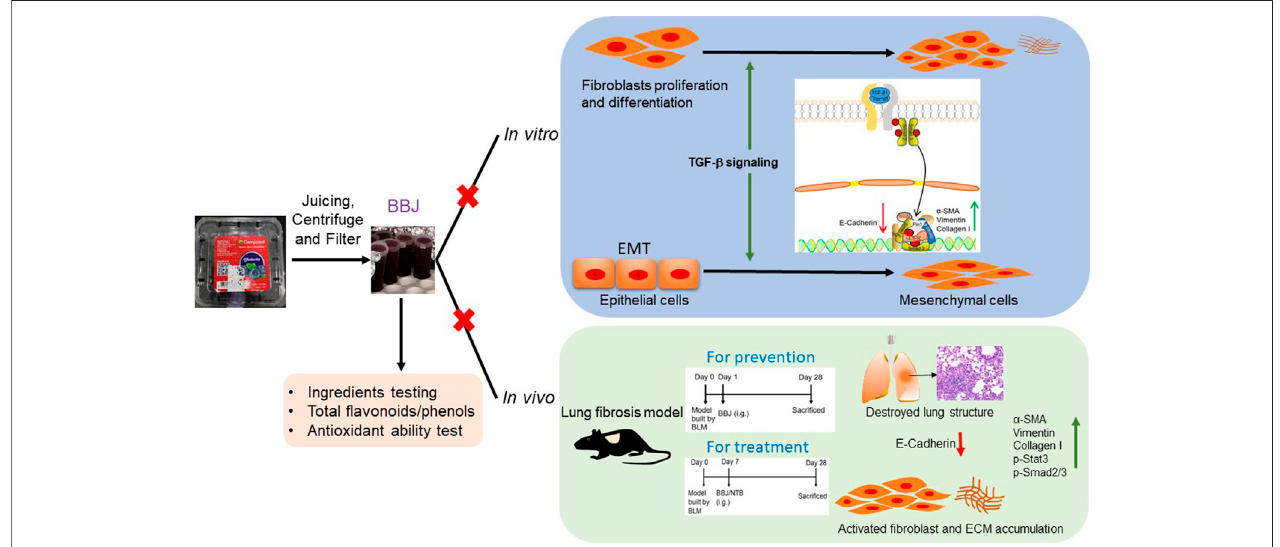
FIGURE 7 | BBJ could inhibit lung fi brosis in vivo and in vitro . Followed by aseriesof processing, BBJ was utilized in assays in vitro and in vivo . BBJ was proven to inhibitEMTinA549.BBJcouldalsosuppress differentiationof fi broblaststomyo fi broblasts inducedbyTGF- β 1provedbythechangesofrelated proteins. Inaddition, in lung fi brosis, the C57BL/6 mouse model built by BLM, BBJ could prevent and ameliorate lung fi brosis by suppressing the Smad2/3 pathway and